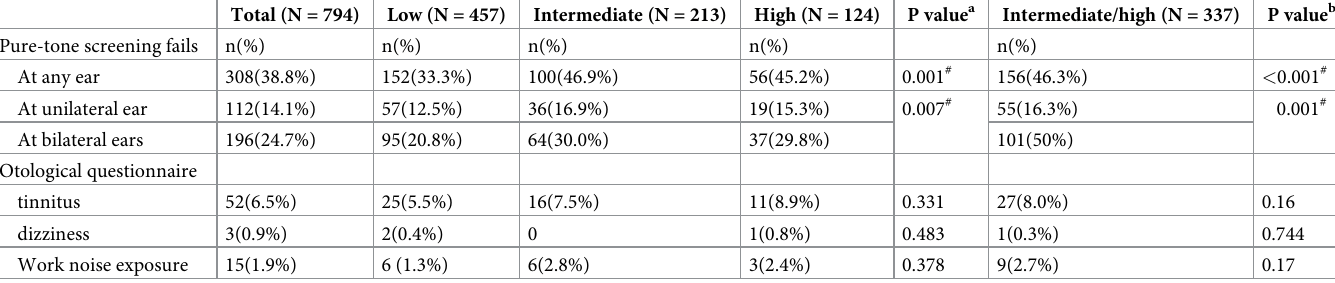
Table 3. Comparing pure-tone screening fails and otologic risk factors grouped by OSA risk based on STOP-BANG scores.